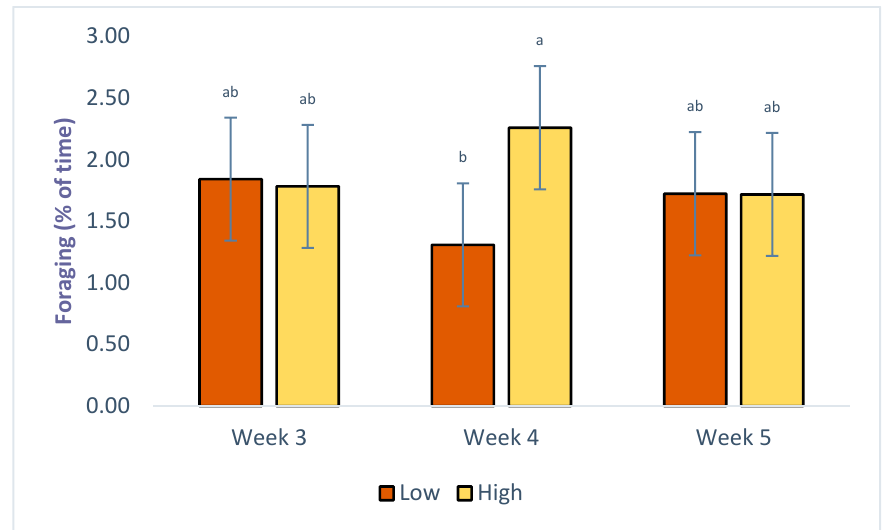
Figure 4. LS Means of the effects of density × week on foraging of commercial-line broilers. Different superscript letters indicate statistically significant differences (Tukey’s HSD test; p ≤ 0.05).